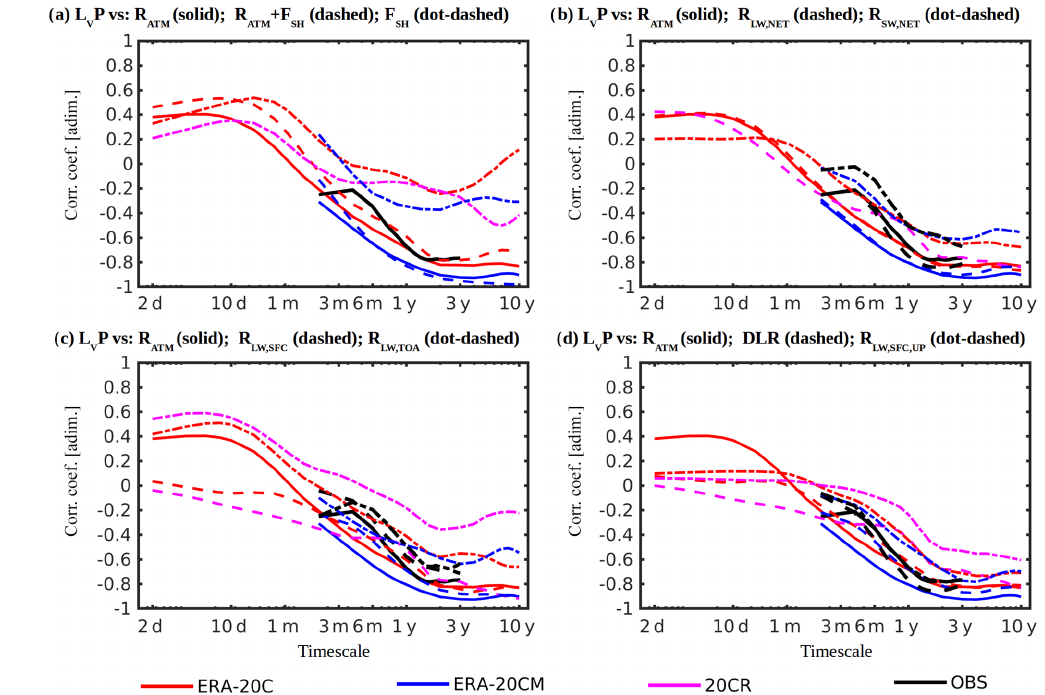
Figure 2. Cross-correlation coefficients against temporal scale computed from Haar fluctuations of (a) L v P vs. R atm (solid), L v P vs. ( R atm + F SH ) (dashed), and L v P vs. F SH (dot-dashed); (b) L v P vs. R atm (solid), L v P vs. R LW , net (dashed), and L v P vs. R SW , net (dot-dashed); (c) L v P vs. R atm (solid), L v P vs. R LW , SFC (dashed), and L v P vs. R LW , TOA (dot-dashed); and (d) L v P vs. R atm (solid), L v P vs. DLR (dashed), and L v P vs. R LW , SFC , UP (dot-dashed). Red lines are computed from ERA-20C, blue lines are from ERA-20CM, pink lines are from 20CR, and black lines are computed from GPCP and CERES-EBAF observational products. Note that R atm and R SW , net were not available from 20CR, while sensible heat flux was not available from